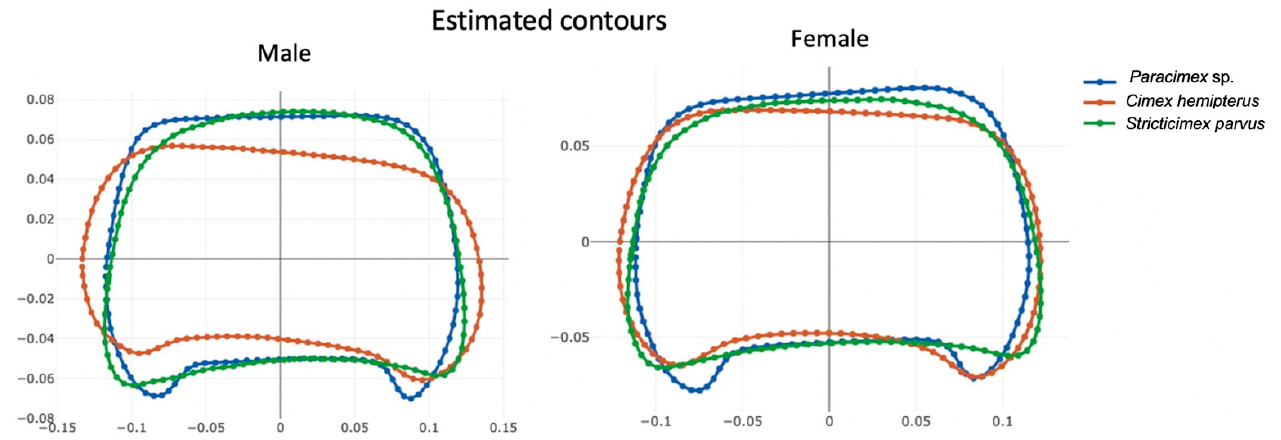
Figure 3. Group means of the ectoparasite outlines, with X and Y axes as reconstructed coordinates after inverse Fourier function.